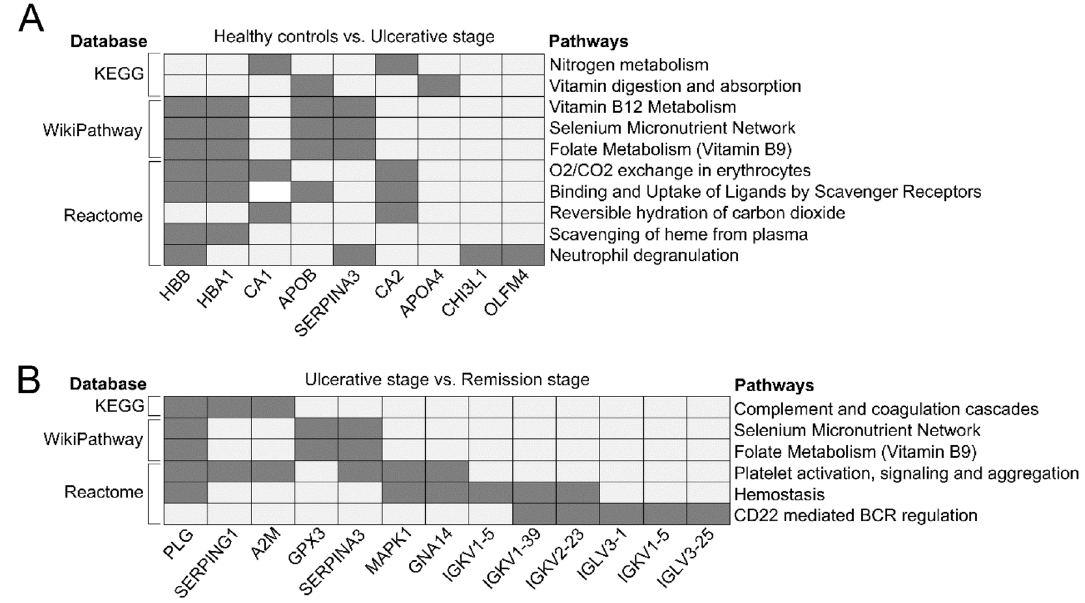
Figure 3. The presence or absence of recurrent aphthous ulcers reveals metabolic pathways for vitamins and nutrients. Each pathway on the right corresponds to a database on the left. The existence of proteins in these pathways is indicated by dark gray squares. APOB and SERPINA3, for example, are proteins involved in the vitamin B9 and B12 metabolism pathways. ( A ) Pathways enriched from the list of differentially expressed proteins between healthy controls and patients at the ulcerative stage. ( B ) Enrichment analysis corresponding to the contrast between the ulcerative and remission-stage patients. The absence of oral ulcers, i.e., the contrast between healthy controls and remission-stage patients, did not show enriched pathways. For enrichment analysis, g:Profiler (https:// biit. cs. ut. ee/ gprofi ler/ gost) and WebGestalt (http:// www. webge stalt. org/) were